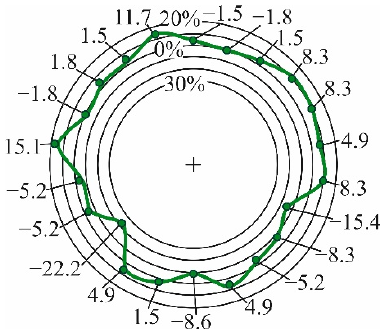
Figure 15. Change in anilox roller ink transfer along the perimeter.